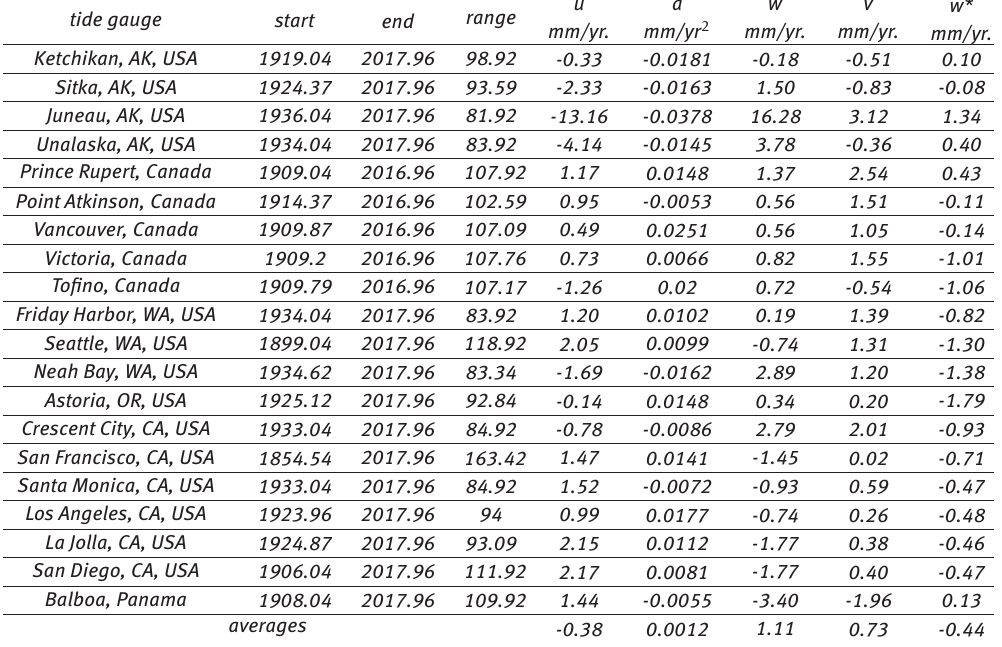
Table 1: Summary of sea-level rise and subsidence results. u is the relative sea-level rise, w is the absolute vertical velocity at the GNSS antenna nearby the tide gauge, and v = u + w is the absolute sea-level